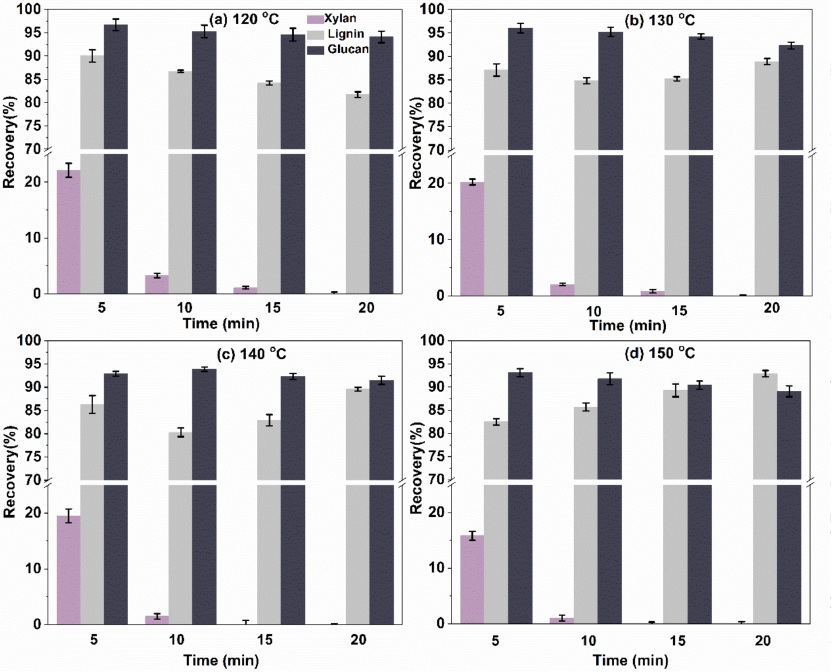
Figure 4. The effect of reaction temperature and time on the recovery of glucan, xylan, and lignin (1:20 solid–liquid